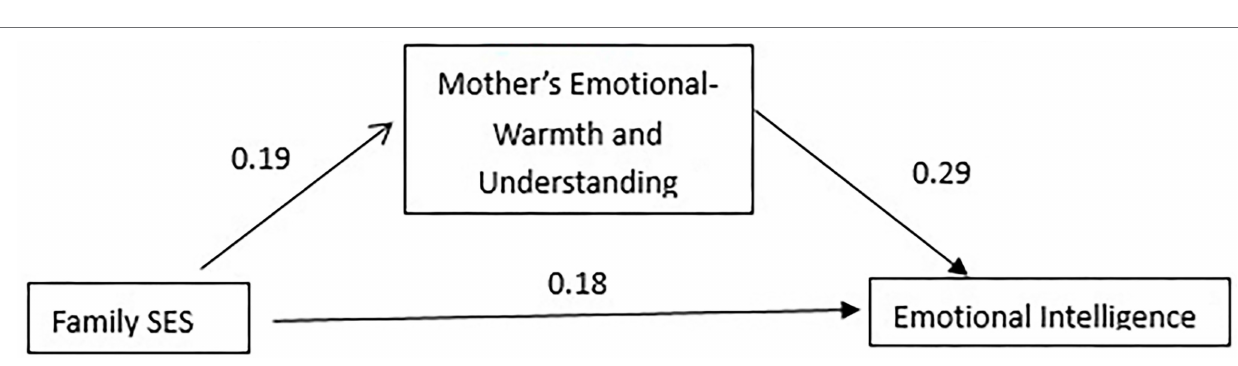
FIGURE 3 | A model diagram of the mediating effect of mother’s emotional warmth and understanding in Jingzhou primary school